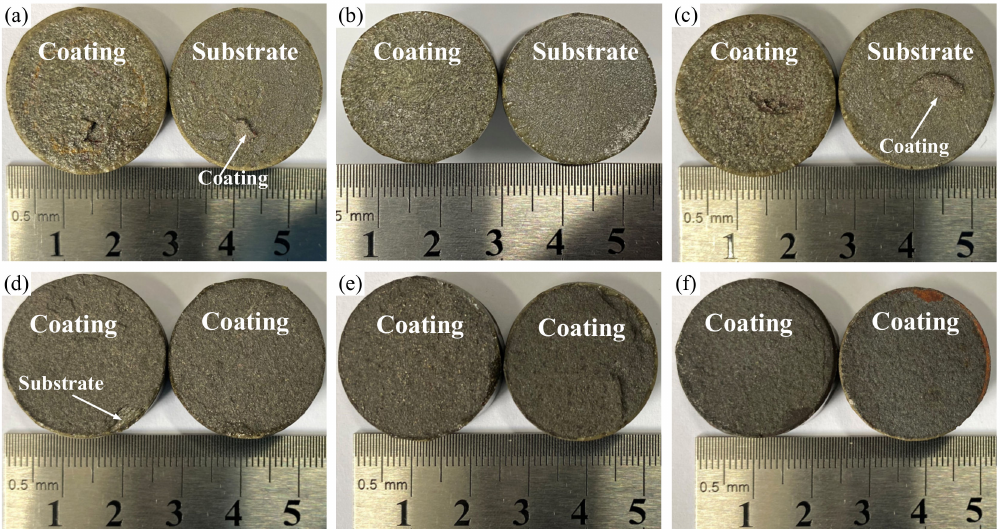
Figure 3. Fracture topography of FeCrAl/Al coatings ( a ) as-sprayed, and coatings annealed at